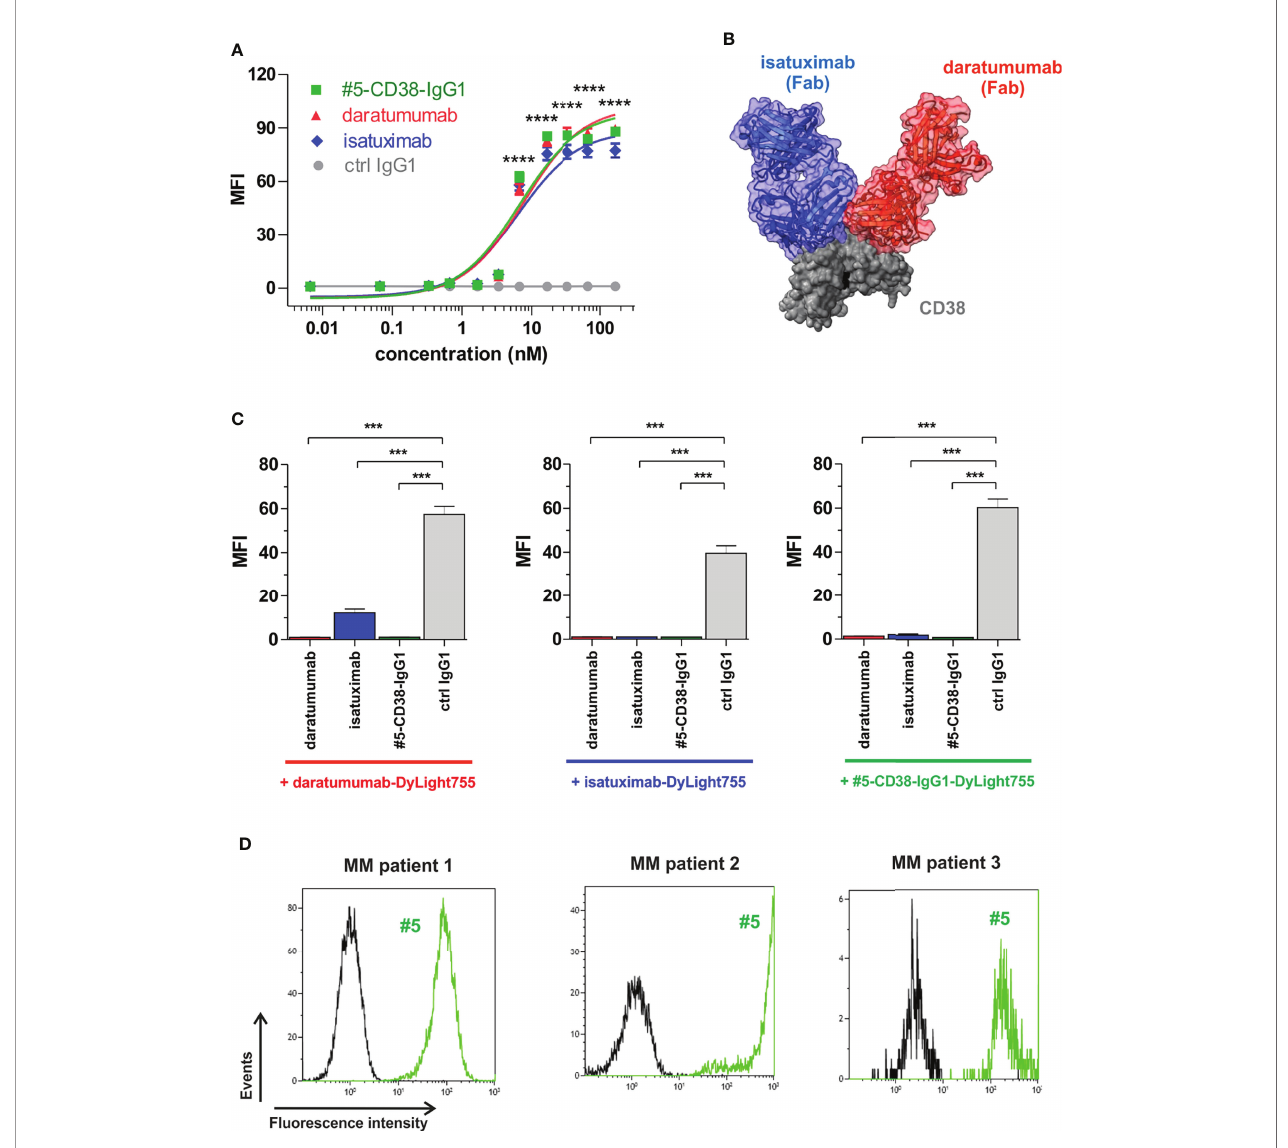
FIGURE 5 | Binding analysis of chimeric antibody #5-CD38-IgG1. (A) L-363 cells were incubated with increasing concentrations of #5-CD38-IgG1 (green), daratumumab (red), isatuximab (blue) and control IgG1 (grey). Antibody binding to cell surface CD38 was detected by goat anti-human Fc F(ab) 2 fragment-FITC and fl ow cytometry. Mean fl uorescence intensity (MFI) ± SEM from three independent experiments are shown. ****p ≤ 0.0001 for CD38 antibodies vs. control IgG1. (B) Structures from co-crystallization of daratumumab Fab (red) and isatuximab Fab (blue) with the extracellular part of CD38 (grey, key residues of the catalytic active side indicated in black) merged by superposition of CD38 according references (36, 37). (C) To check for overlapping epitopes of #5-CD38-IgG1 with daratumumab or isatuximab on cell surface expressed CD38, 0.2 x 10 6 L-363 cells were pre-incubated with 1 mg/ml #5-CD38-IgG1, daratumumab, isatuximab or control IgG1 prior incubation with 5 µg/ml DyLight755-labeled daratumumab (left graph), isatuximab (middle graph) or #5-CD38-IgG1 (right graph) and subsequently analyzed by fl ow cytometry. MFI ± SEM from three independent experiments are shown. ***p ≤ 0.001. (D) MNC from BM aspirates of three myeloma patients with 27% (left histogram), 4% (middle histogram) and 0.8% (right histogram) CD138-positive plasma cells, respectively, were checked for binding of FITC-labeled #5-CD38-IgG1 (#5, green) and corresponding control IgG1 antibody (black) by fl ow